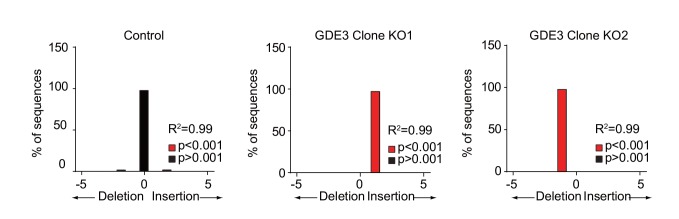
GDE3 knockout validation.GDE3 knockout in MDA-MB231 cells was achieved using CRISPR/Cas9 genome editing. Surviving colonies were screened for cassette integration and indels into the query gene by PCR. Two genetically individual clones (KO1 and KO2) were selected, and knockout was confirmed using Sanger sequencing followed by TIDE deconvolution (Brinkman et al., 2014).